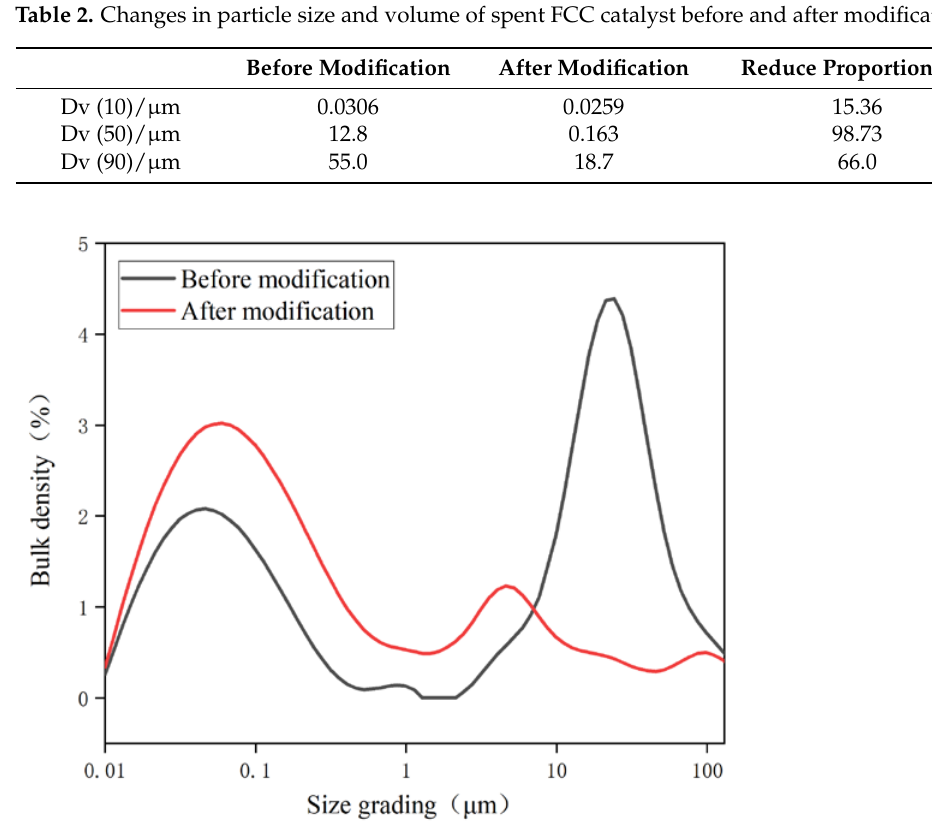
Figure 3. Particle size distribution of spent FCC catalyst.